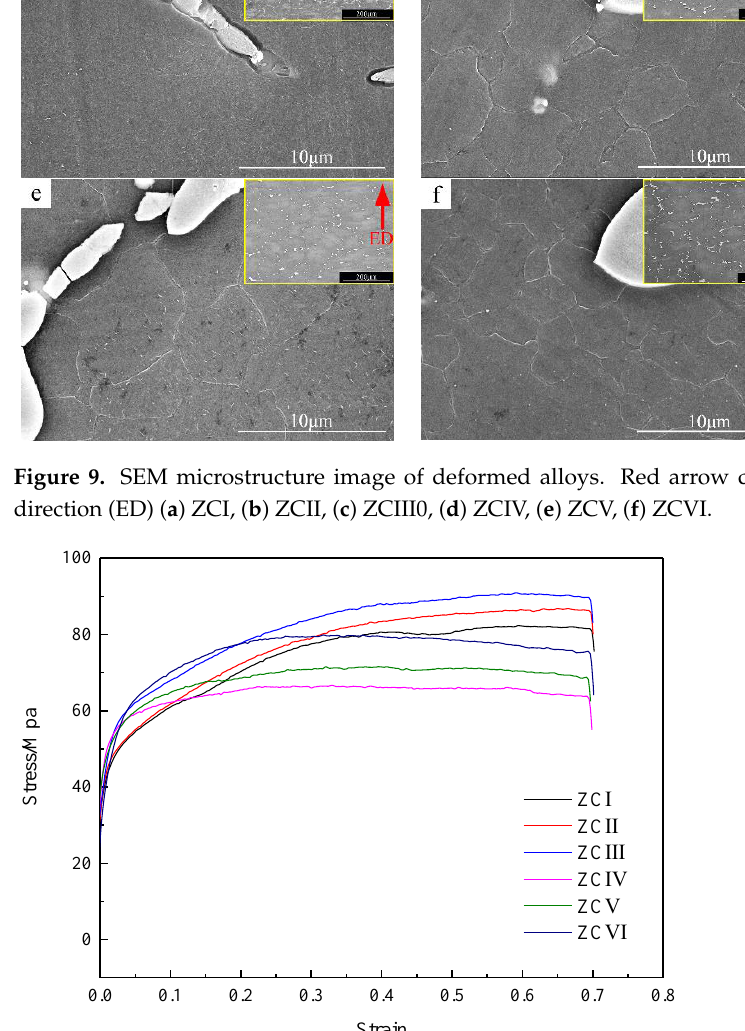
Figure 10. Stress – strain curve of experimental alloy. In order to deeply investigate the microstructural characteristics of dynamic recrys- tallized grains during the thermal deformation of Mg-Zn-Ce-Zr alloy, the average size (μm), average area (μm 2 ) and area ratio of recrystallized grains (shown in Table 5) were obtained by extracting the recrystallized grains with image analysis software (as shown in Figure 11). The results show that the change of Ce content and of Zn content can obvi- ously affect the microstructure characteristics of recrystallized grains, and the increase of Ce or Zn content alone can reduce the size of dynamic recrystallized grains and the area ratio of recrystallized areas. The content of Ce and of Zn in ZCVI alloy is the highest, which has the most significant effect on dynamic recrystallization, and the recrystalliza- tion area ratio increases greatly.